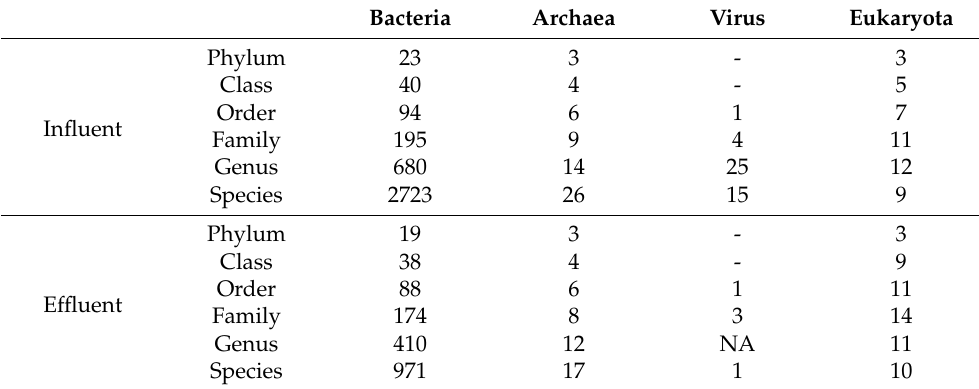
Table 2. Number of taxonomic units in influent and effluent